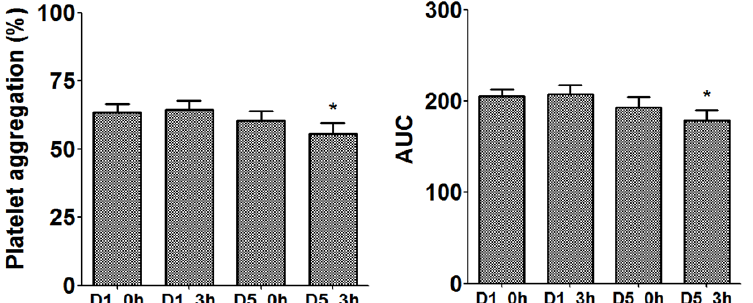
Figure 2. Inhibition of platelet aggregation (ADP 4 µmol/L) by 1 g tomato pomace extract. Platelet aggregation results are shown on the basis of percentage of platelet aggregation and area under the curve (AUC). The graphs depict mean ± SEM. Difference between Day 1 (d1)_0 hours (0 h) and Day 5 (d5)_3 hours (3 h) was analyzed using the Wilcoxon signed-rank test; * p < 0.05.